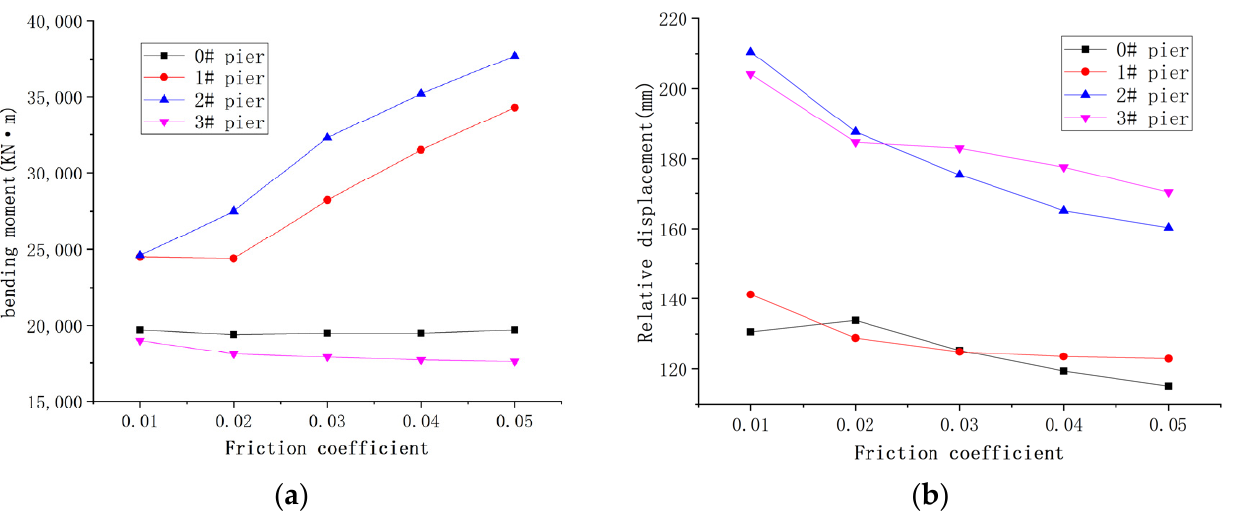
Figure 11. Seismic response of the longitudinal bridge direction (friction coefficient μ ). ( a ) Bending moment at the bottom of pier. ( b ) Relative displacement between piers and beams. When the friction coefficient changes from 0.01 to 0.05, the relative displacement between piers and beams decreases significantly, and the bending moment at the